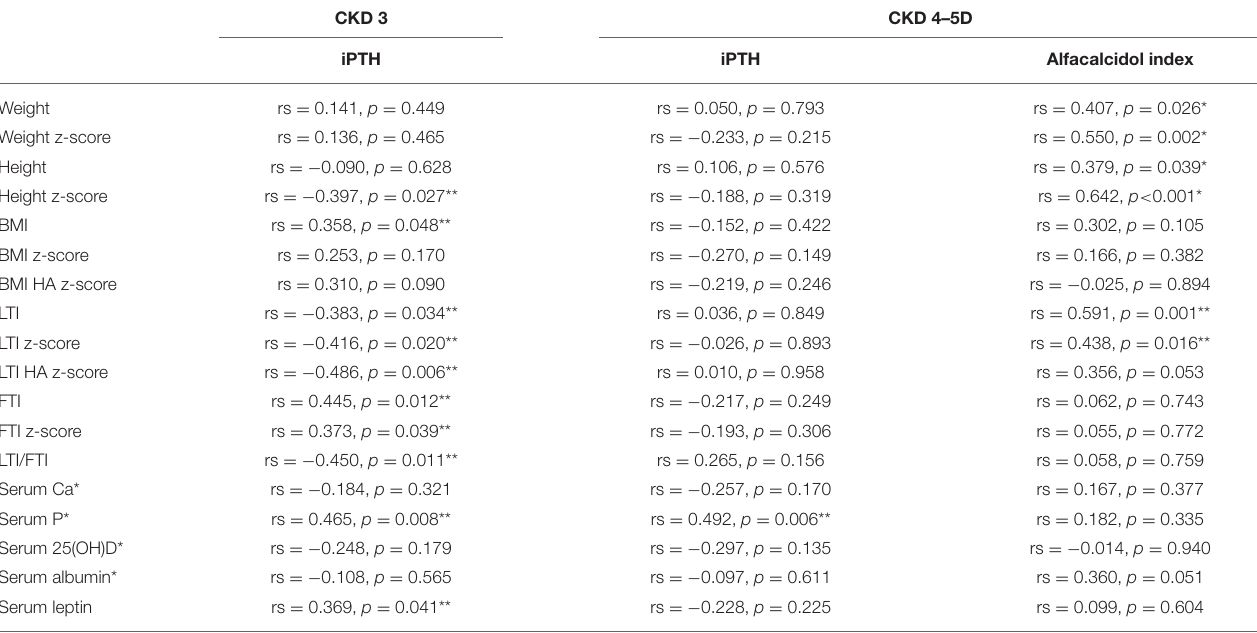
TABLE 2 | Spearman correlation analysis of anthropometric parameters, body composition indices and laboratory data with serum intact parathormone (iPTH) in chronic kidney disease (CKD) stage 3 patients and with 6-month mean iPTH and alfacalcidol index [(mcg/week per pg/ml of PTH) × 1,000] in CKD stage 4,5D patients. CKD 3 CKD